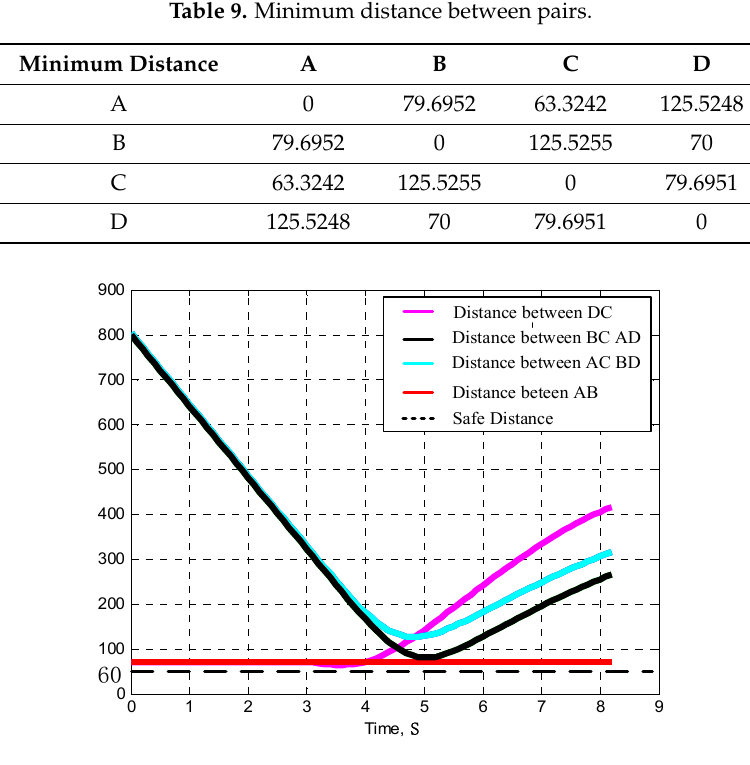
Figure 20. Relative distance.